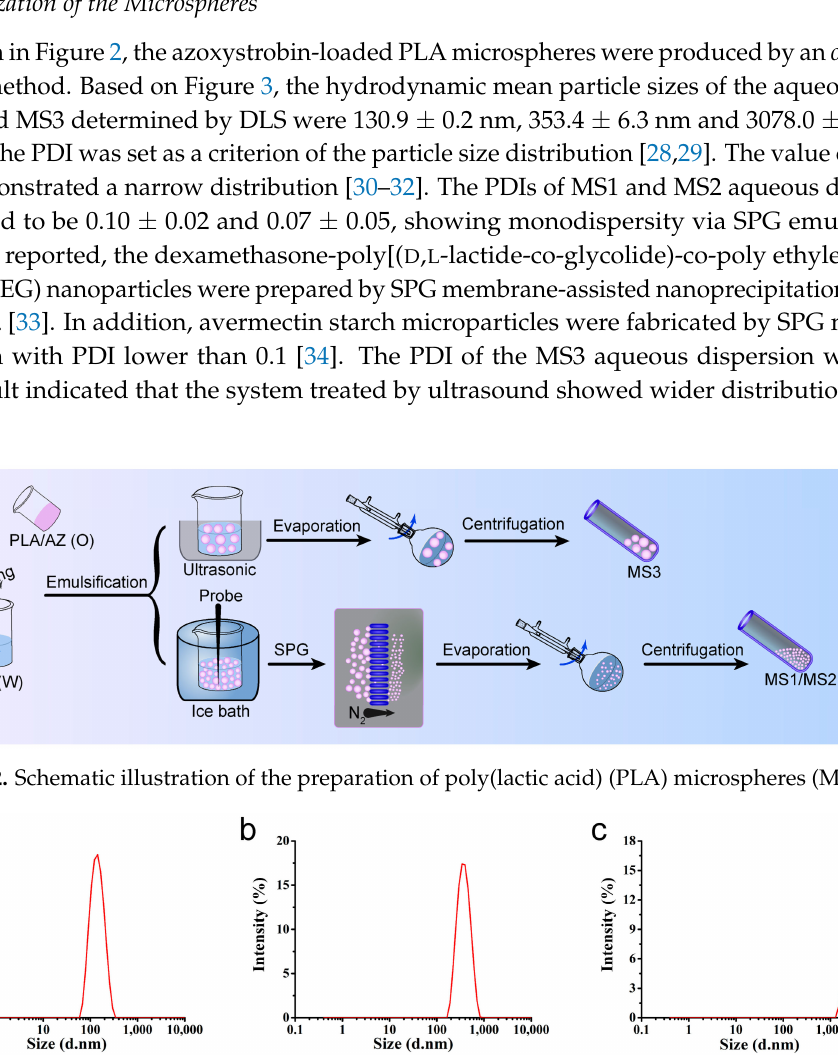
Figure 3. Hydrodynamic particle size of the azoxystrobin microspheres. ( a ) MS1; ( b ) MS2; ( c )